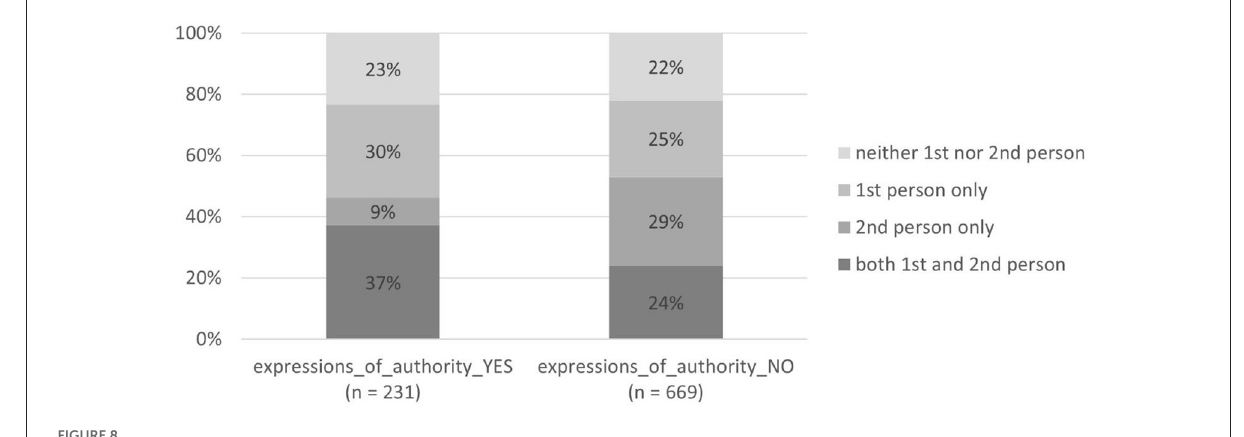
FIGURE8 Expressions of authority and types of person usage.